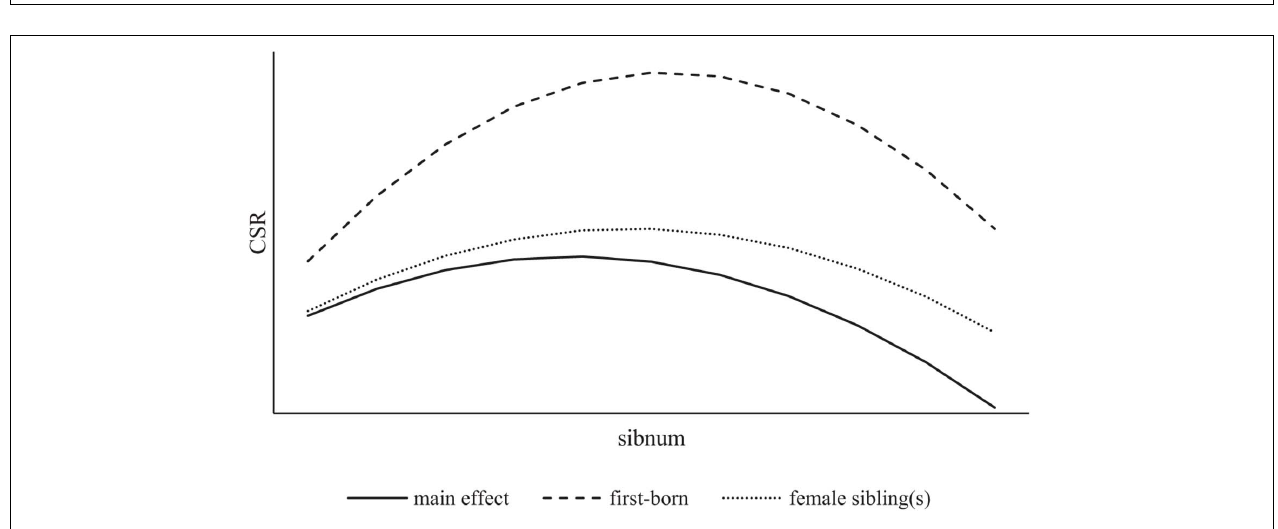
FIGURE 2 | Moderating effect of birth order and female